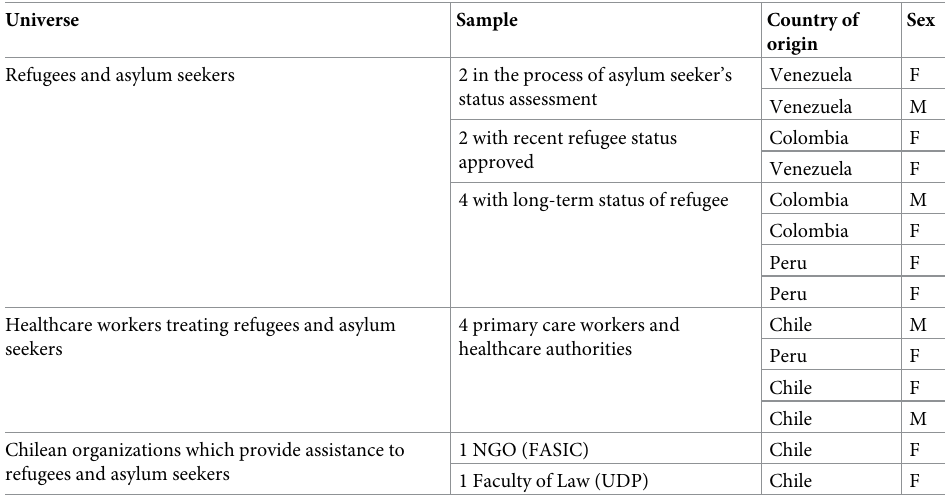
Table 1. General socio-demographic characteristics of